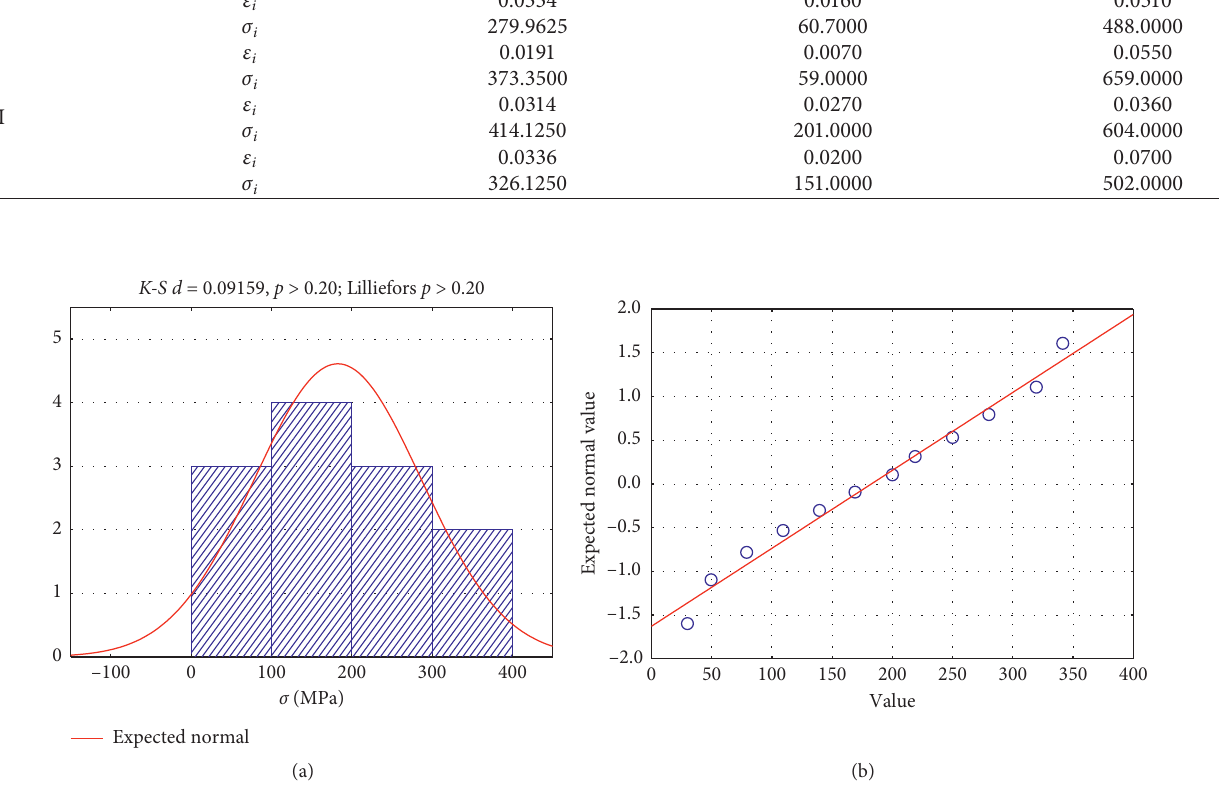
Figure 4: The distribution histogram of the stress experimental values with the overlaid curve of the expected normal distribution (a) and the graph of the normal distribution (b) for the deposited samples of group